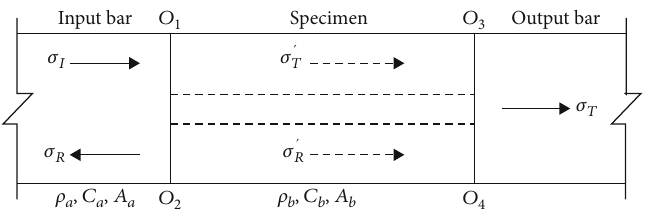
Figure 14: Transmission and re fl ection of a one-dimensional compressional wave in a rock sample.